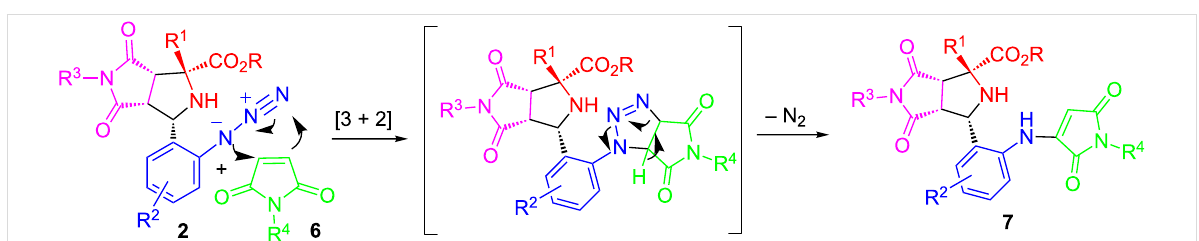
Figure 3: X-ray structure of 7h .